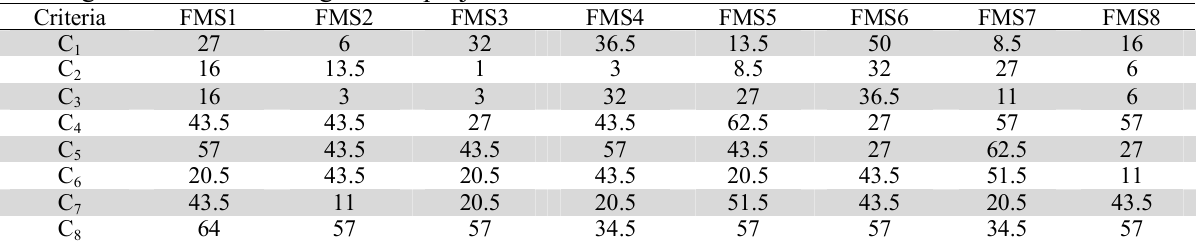
Mean global Besson rankings of the projections in ORESTE method